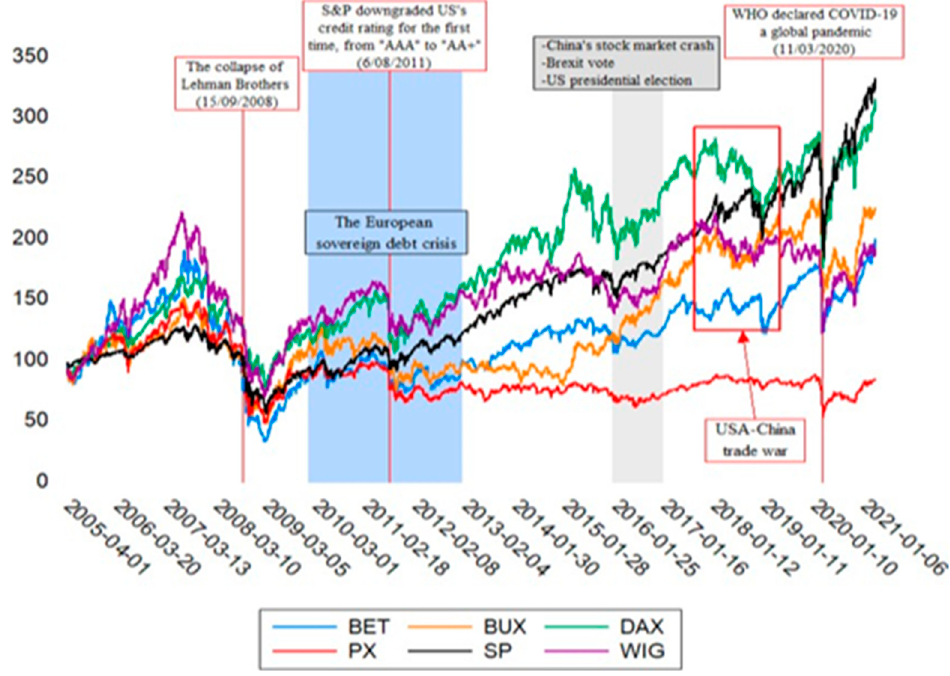
Figure 1. The evolution of the stock market indices.